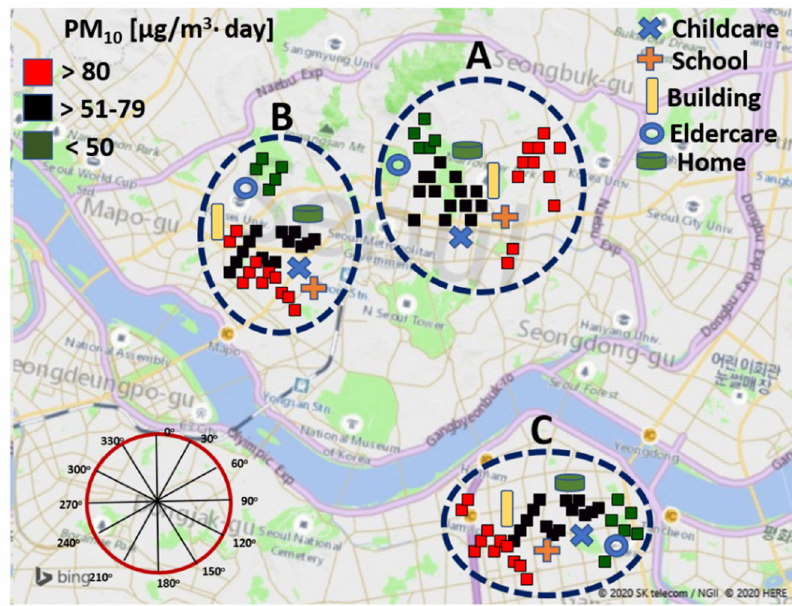
Figure 1. Sampling locations (A, B and C group for indoors of childcare, school, commercial building, elderly and homes for indoors and O for outdoor) with the plots of outdoor PM 10 using R statistical software and Microsoft 3D